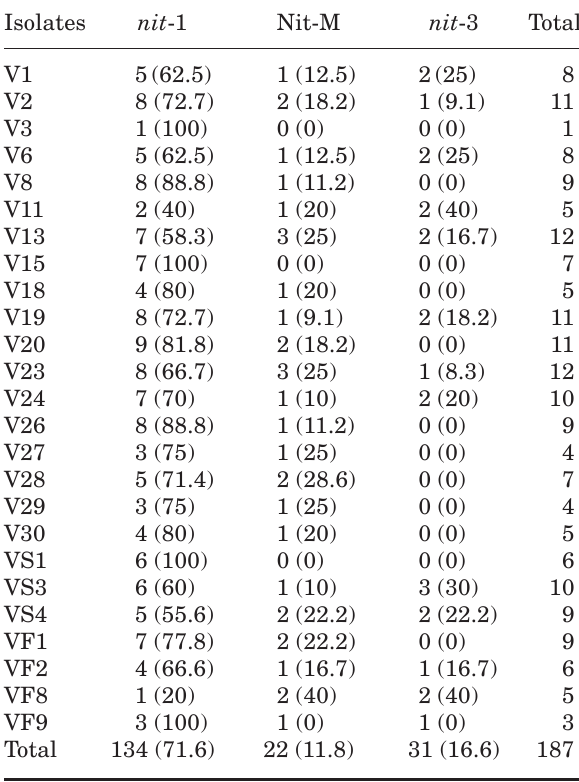
Table 2. Number and percentage (in brackets) of each Verticillium dahliae nit - mutants selected on character- ization